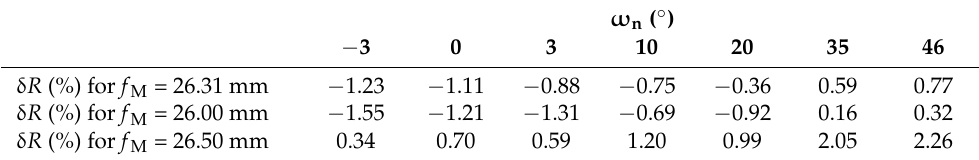
Table 7. Distance percentage errors δ R (%) for different model focal